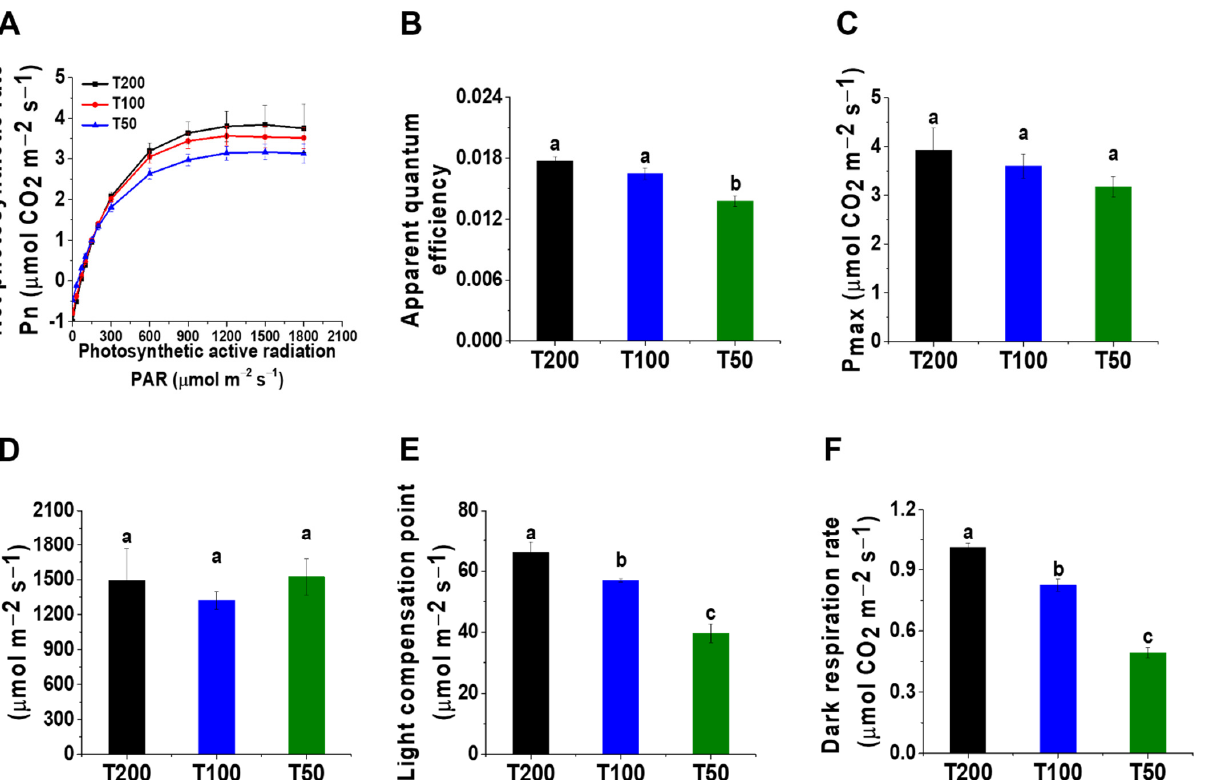
Figure 6. The light response curve of cigar tobacco seedlings under different light intensities ( A ). The characteristics of the light-response curve such as apparent quantum efficiency ( B ), net photosynthesis rate ( C ), light saturation points ( D ), light compensation points ( E ), and dark respiration ( F ) are presented as means ± SE. The lowercase letters on each column show significant differences at p < 0.05 using the LSD test. T200 symbolizes the seedlings under a light intensity of 200 µ mol m − 2 s − 1 ; T100 symbolizes the seedlings under a light intensity of 100 µ mol m − 2 s − 1 ; and T50 symbolizes the seedlings under a light intensity of 50 μ mol m − 2 s − 1 .